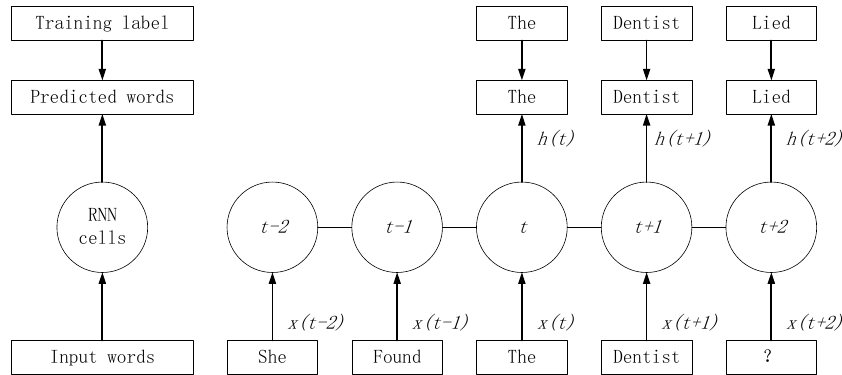
Figure 6. Application of recurrent neural network in natural language processing . “ t ” means the word step while “ t − 1 ” means the previous step of “ t ”. The “ h(t) ” means the output of step “ t ” and the “ x(t) ” means the input of step “ t ”. The “?” means the word that needs to be predicted corresponding to the predicting result word “Lied”.